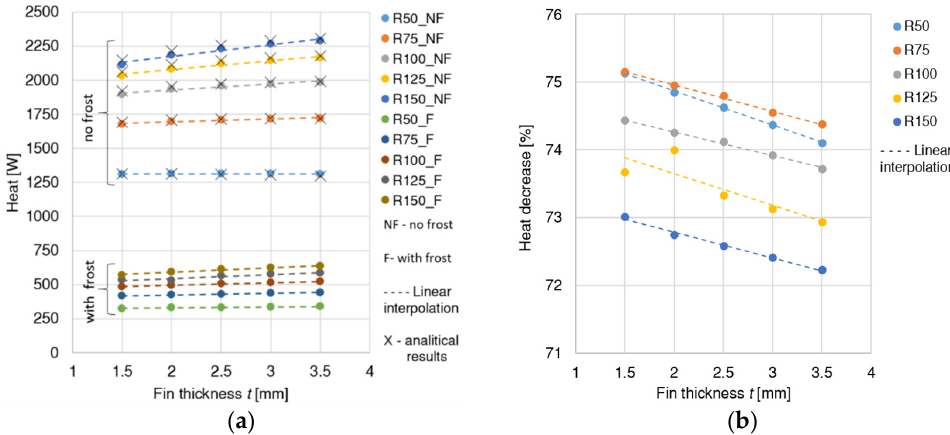
Figure 18. ( a ) Heat transferred through the 1 m length of the finned tube with 16 fins, ( b ) Heat decrease due to frosting.